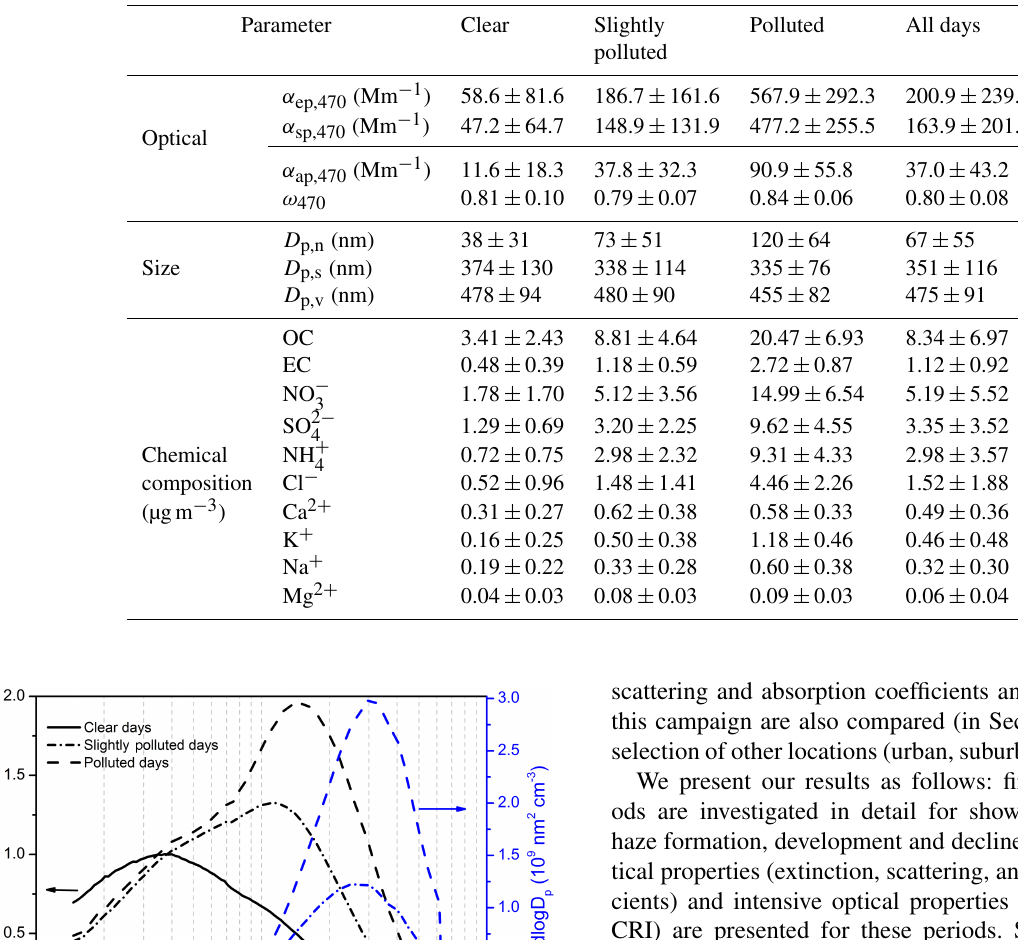
Table 1. List of the mean optical values (aerosol extinction, scattering, absorption coefficients, and SSA at λ = 470nm), the effective mode diameters (particle number, surface area and volume, fitted values from the measured submicron size distribution with mono-lognormal distribution function), and chemical composition of PM 1 . 0 particles observed in this campaign. These parameters were classified into three different pollution levels (clear, slightly polluted, and polluted days).